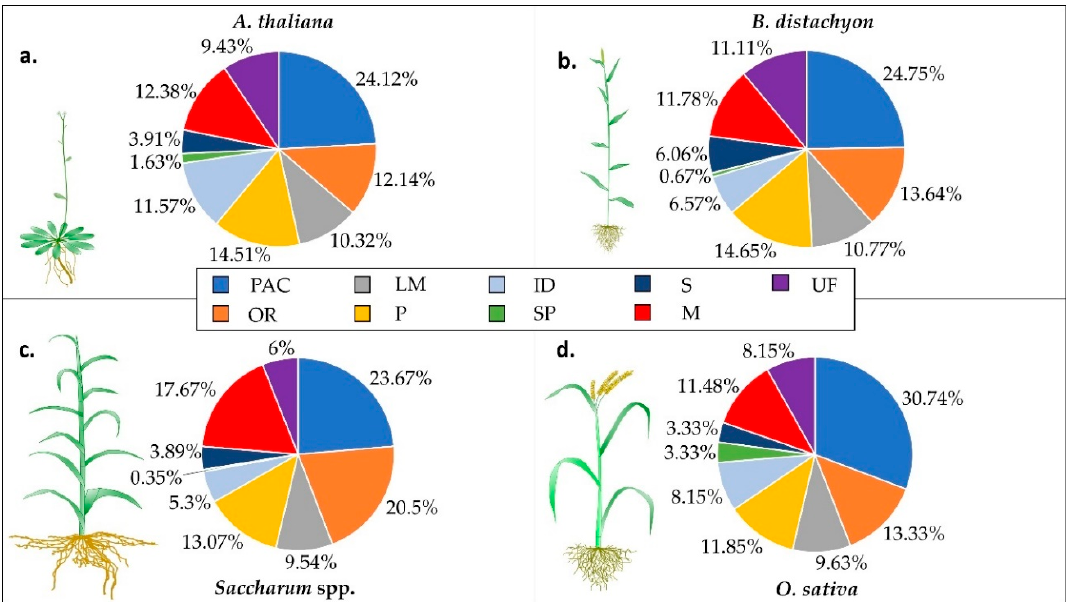
Figure 1. Percentage of CWP functional classes in the species A. thaliana ( a ), B. distachyon ( b ), Saccharum spp. ( c ) and O. sativa ( d ). Plant drawings are not to scale. Functional class abbreviations: proteins acting on carbohydrates (PACs), oxidoreductases (ORs), proteases (Ps), proteins related to lipid metabolism (LMs), proteins possibly involved in signaling (Ss), proteins with predicted interaction domains (IDs), miscellaneous proteins (Ms), proteins of unknown function (UFs) and structural proteins (SPs).